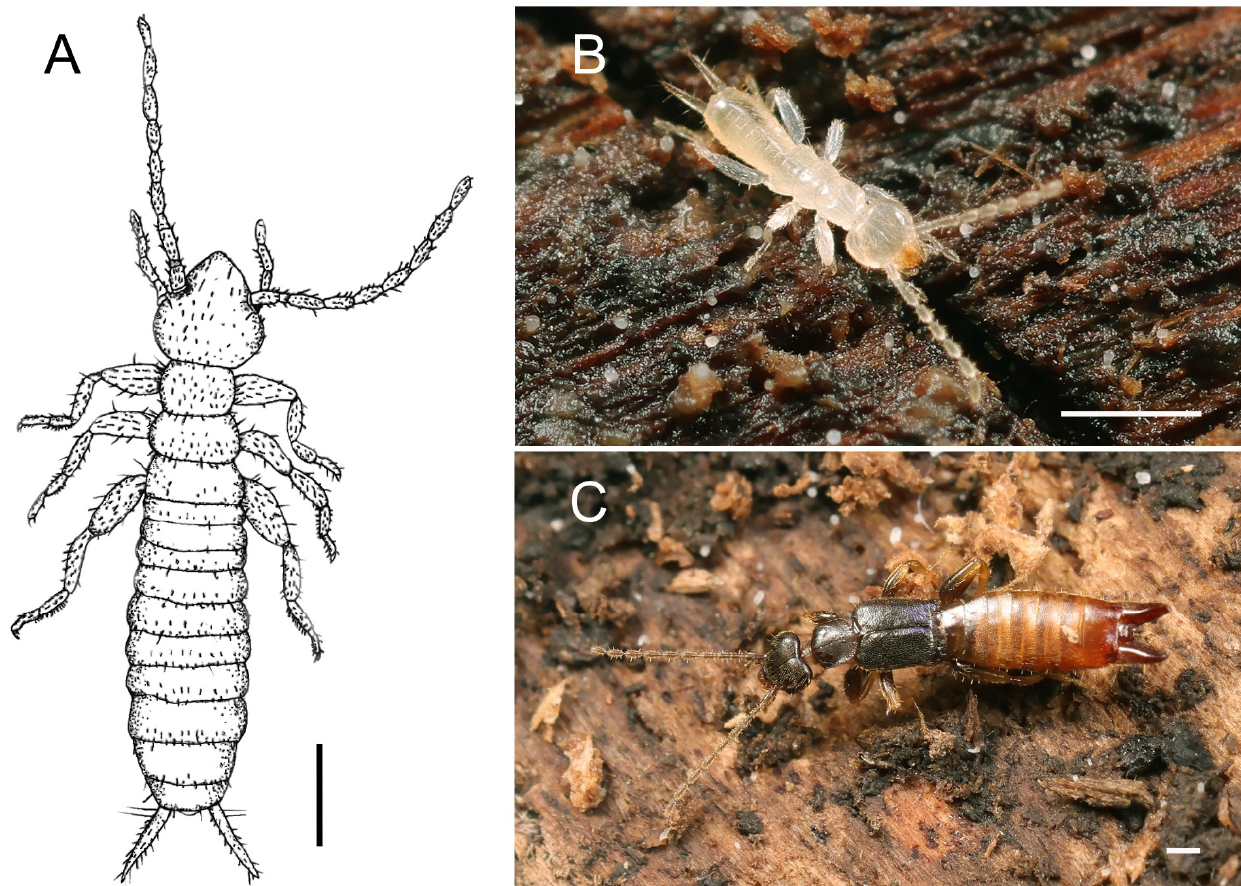
Figure 1. Formosozoros newi (Chao & Chen, 2000) ( A ) and Paralabellula curvicauda (Motschulsky, 1863) ( B , C ). Dorsal view on F. newi redrawn from the original description (Chao & Chen 2000) ( A ); 1st-instar nymph of P. curvicauda from a breeding culture ( B ); and adult female of P. curvicauda from a breeding culture ( C ). Figure A reproduced with permission from Pan-Pacific Entomologist published by the Pacific Coast Entomological Society in 2000. Scale bars = 0.5 mm.